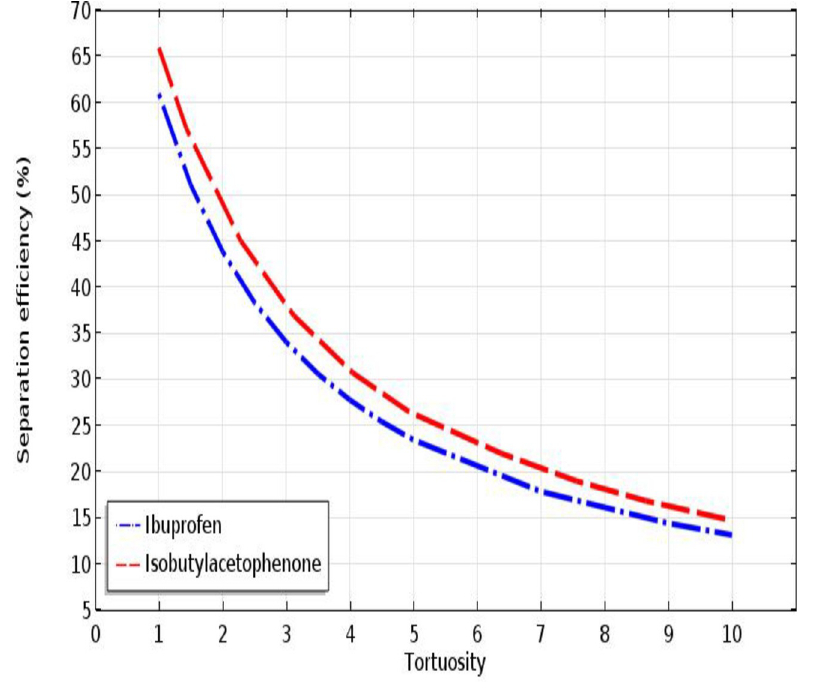
Fig 9. Effect of tortuosity parameter on the IP and 4-IBAP solutes molecular separation.